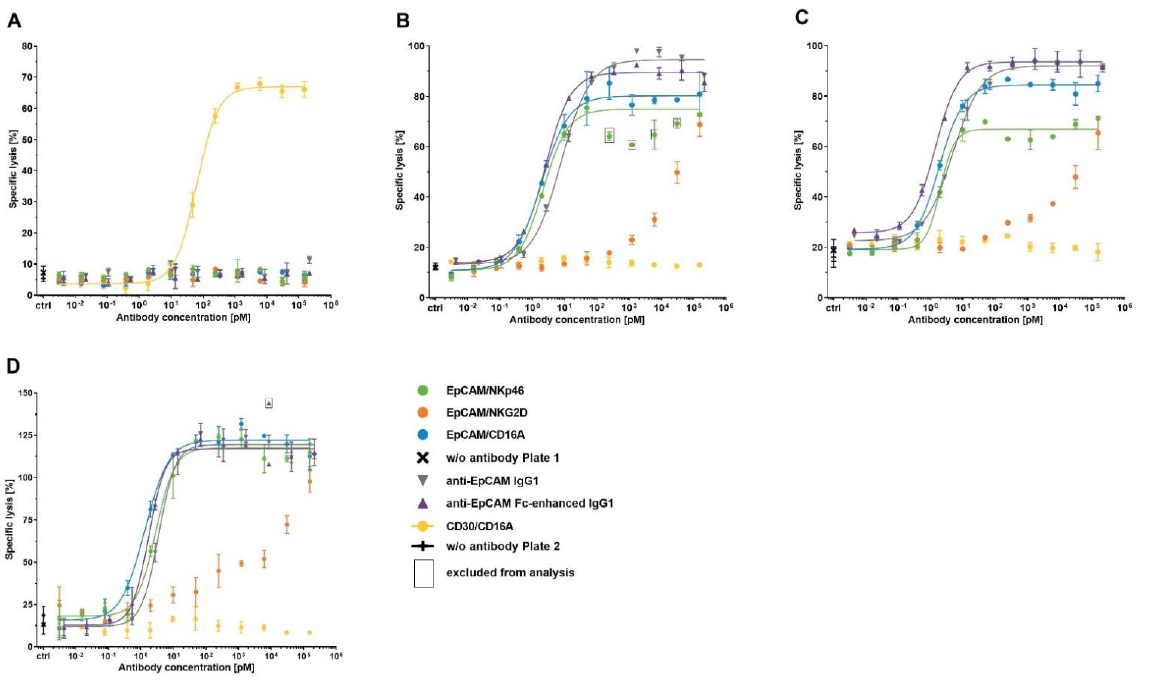
Figure 6. Specificity of bispecific ICE ® constructs to induce EpCAM + tumor cell lysis. Calcein-labeled KARPAS-299 ( A ), HCC-1954 ( B ), Detroit 562 ( C ), and HCC-1187 cells ( D ) were co-cultured with enriched primary human NK cells as effector cells at an E:T ratio of 5:1 in the presence of serial dilutions of the indicated antibodies. After a 4 h incubation, the levels of calcein fluorescence released from the lysed target cells into the supernatant were quantified and used for the calculation of the percentage of specific lysis. Mean of duplicate values ± standard deviation are plotted. For specific constructs in different cell lines, fitting of sigmoidal dose–response curves was not possible. E:T, effector-cell-to-target-cell ratio. Table 7. Cytotoxicity of bispecific ICE ® constructs and control antibodies tested on target tumor cells with or without EpCAM and CD30 expression.